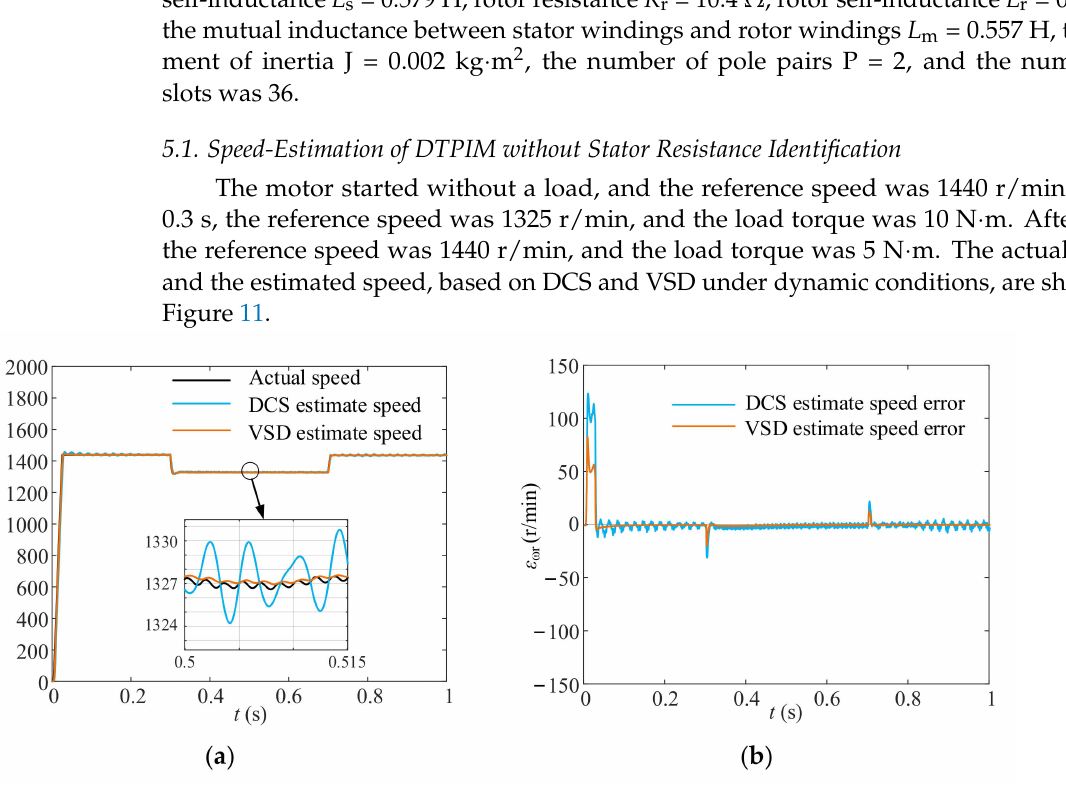
Figure 11. Actual speed and speed-estimation results under dynamic conditions. ( a ) Speed; ( b ) Speed